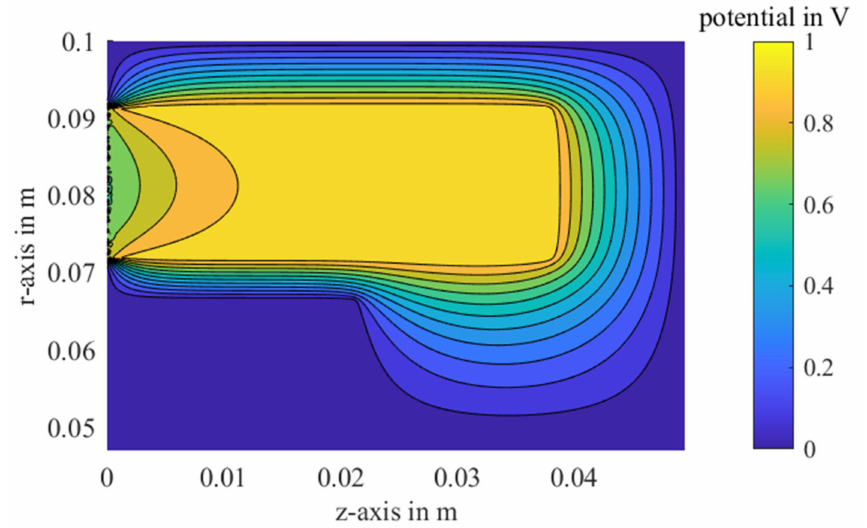
Figure 7. Visualization of analytically calculated equipotential lines in the end-winding model.